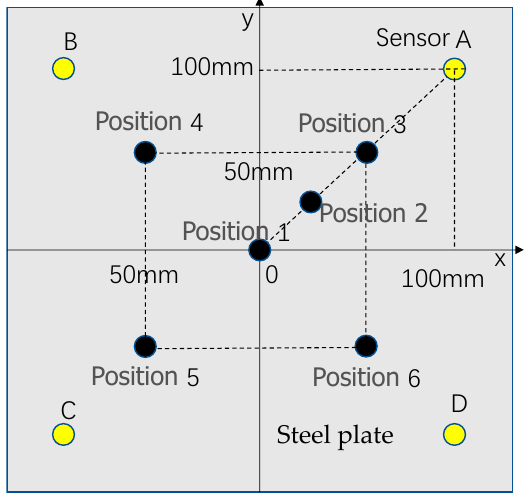
Figure 17. The set impact position.